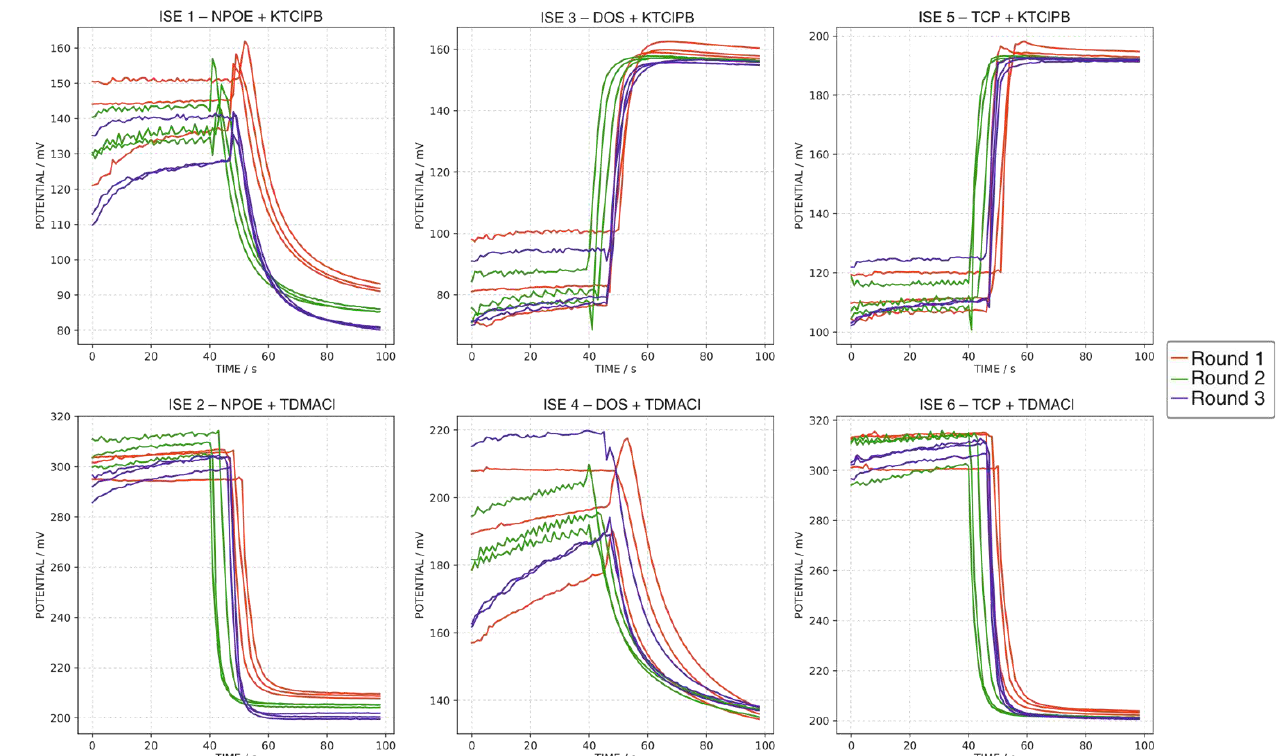
Figure 5. Triplicate dynamic potential responses of ISEs 1 – 6 observed for the MT sample at the beginning, middle and end of the entire experimental testing of the sample pool, applying the first measurement protocol (1.0 × 10 −6 M KCl background).